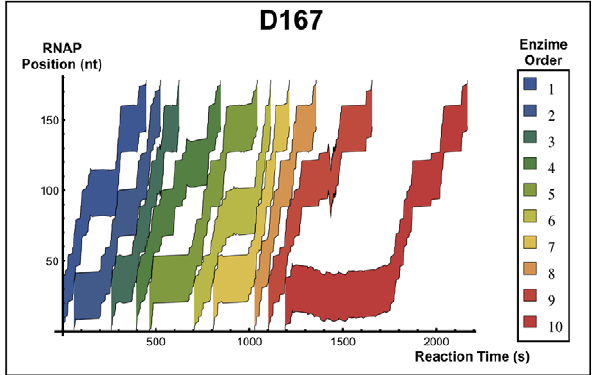
Figure 5. RNAP position in function of reaction time during a simulation of the MRA : We can see the kinetic behavior of the RNAP during the MRA for sequence D167: the evolution in time of the position of the enzyme in the DNA strand. Each region represents the space occupied by the enzyme during transcription, and the colors indicate the binding order to the DNA strand. Note that there is no overlap between the regions. Points where the regions touch each other indicate the occurrence of a collision between the molecules. The colored regions represent the space occupied by the enzymes during the reaction. Sites where molecules take longer dwell time to continue transcription and backtracking sites are easy to identify. The collisions between the molecules usually occur at the pause candidate sites.